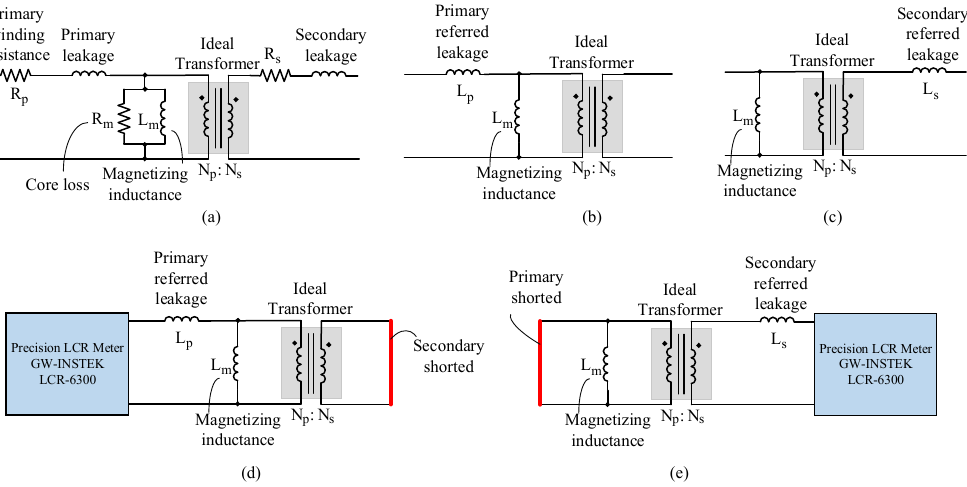
Figure A2. Leakage model of high-frequency transformer ( a ) model of a transformer (page 56 in [23]) ( b ) primary referred leakage omitting resistance losses ( c ) secondary referred leakage omitting resistance losses ( d ) measurement of primary referred leakage (short circuit test) ( e ) measurement of secondary referred leakage (short circuit